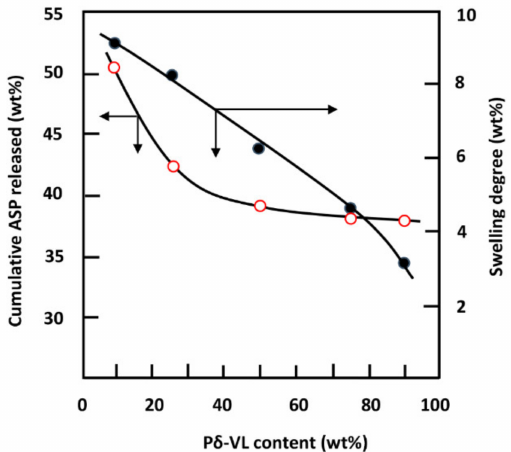
Figure 15. Variations of the cumulative ASP released from the ASP-7/PE- co -VAL/P δ -VL drug carrier system and the swelling degree of PE- co -P δ -VL in neutral pH media versus the P δ -VL